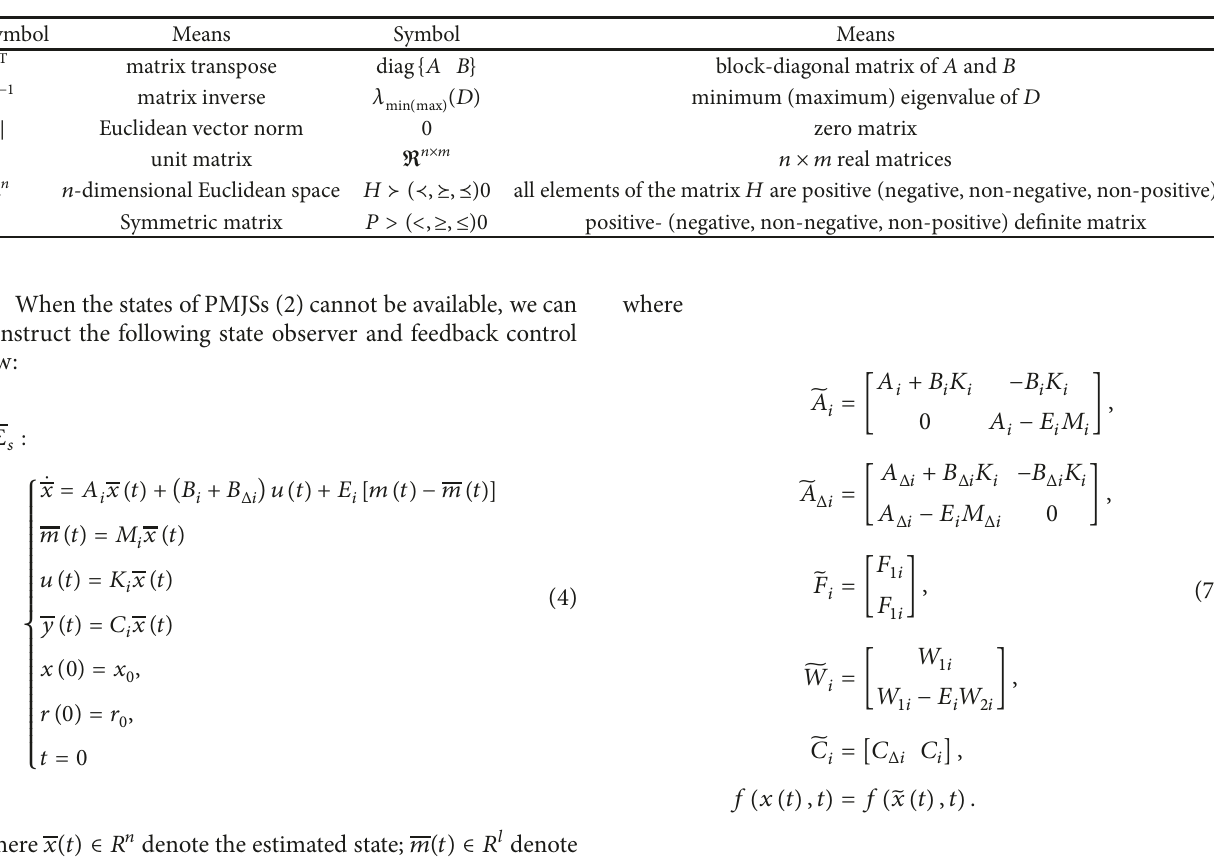
Table 1: Symbols throughout this